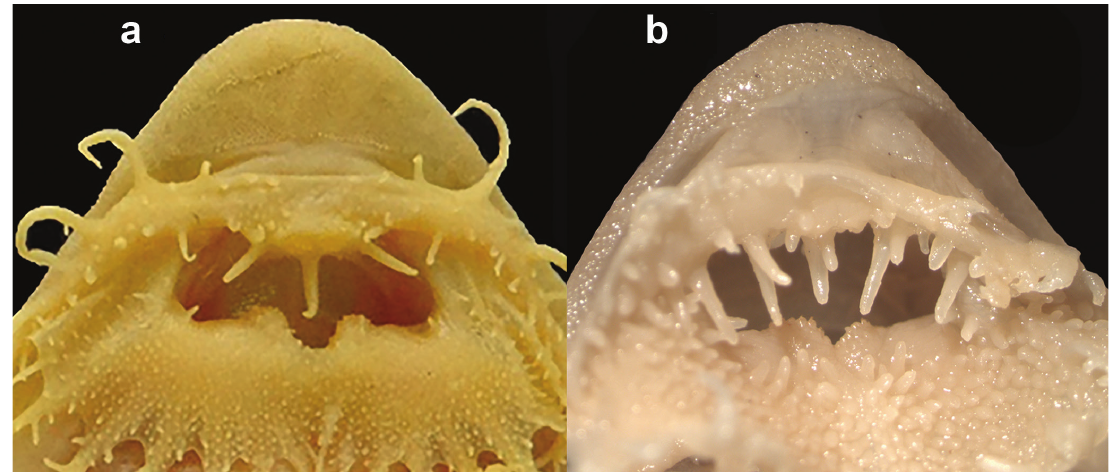
Fig. 6. Detail of buccal ornamentation. a. Pseudohemiodon unillano , paratype, MBUCV-V-20148, 166.9 mm SL; b. Crossoloricaria venezuelae, MBUCV-V-2175, 57.8 mm